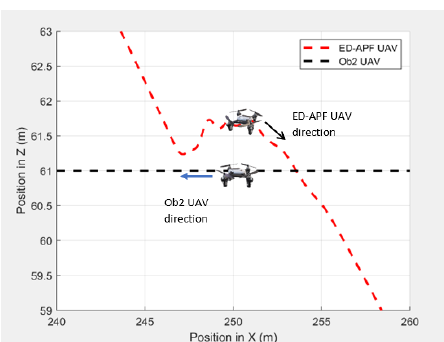
Figure 26. The UAV’s planned path for dynamic obstacle avoidance when encountering another UAV